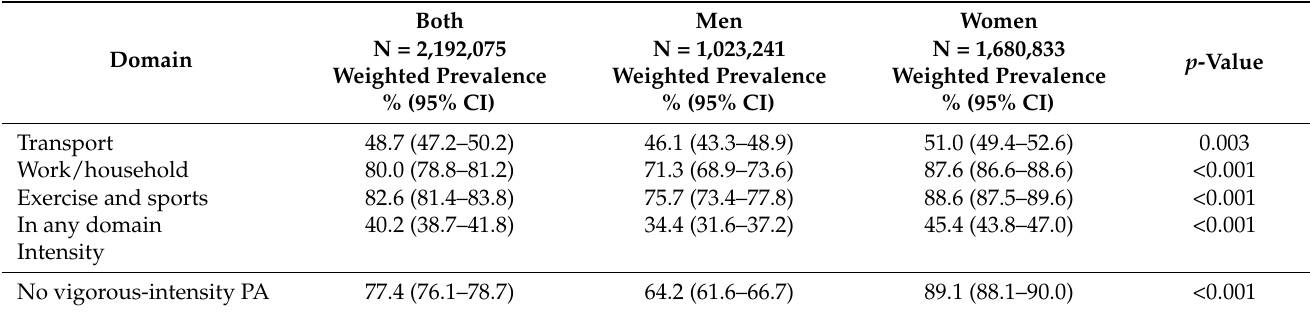
Table 2. No physical activity by domain and in any domain and no vigorous-intensity physical activity stratified by sex among participants aged 18–69 years. Panama, 2019.